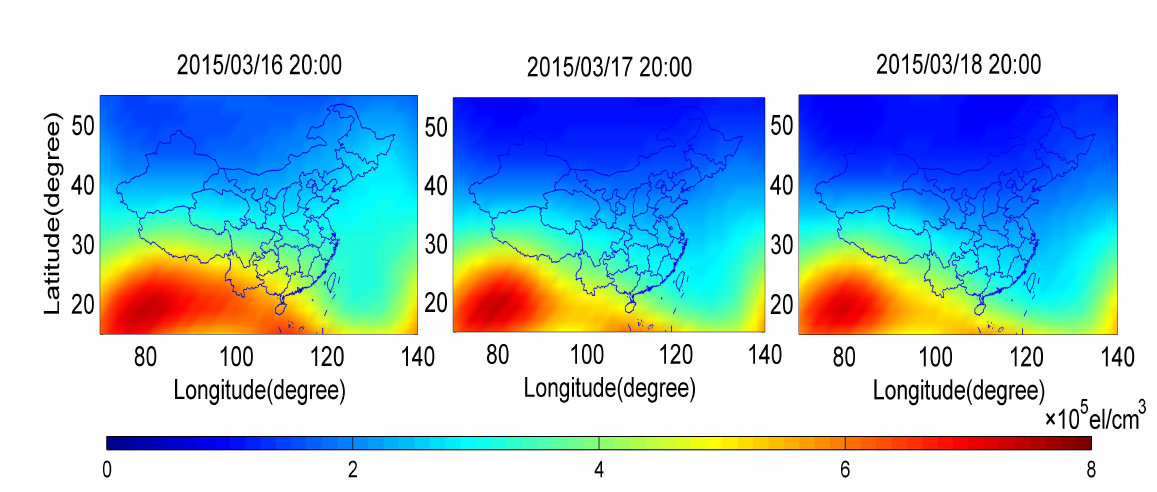
Figure 9. Horizontal distribution of IED at UTC 20:00 from 16–18 March 2015 (H = 350